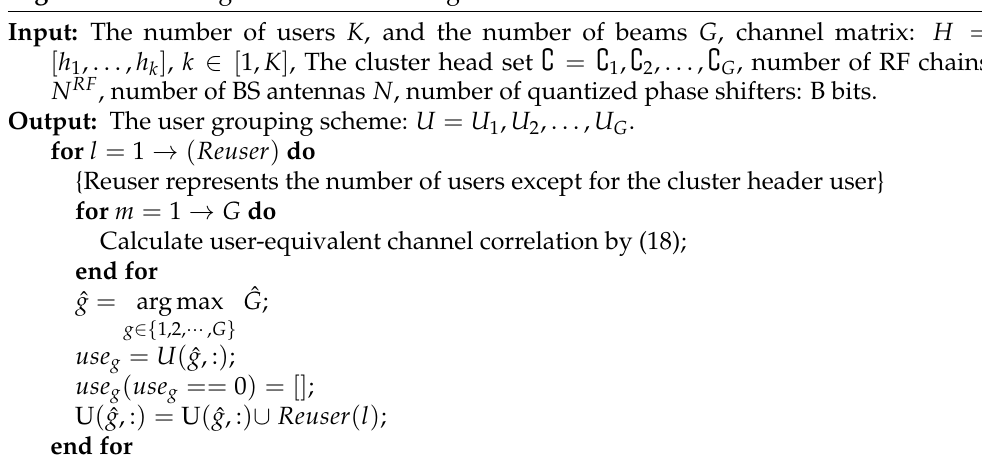
Algorithm 2 The algorithm of attributing users to